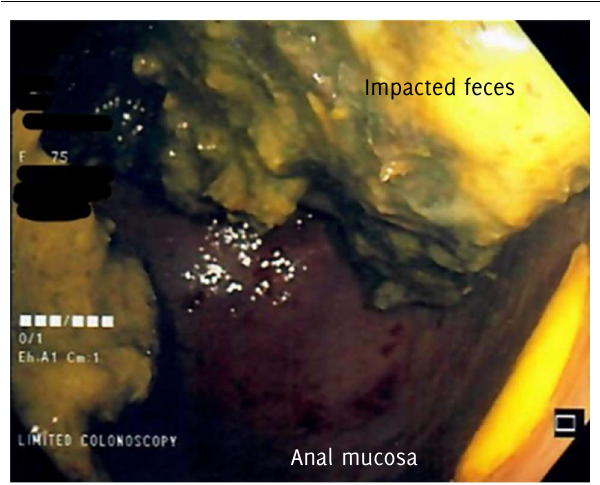
Figure 1 . Colonoscopy Showing Impacted Feces.